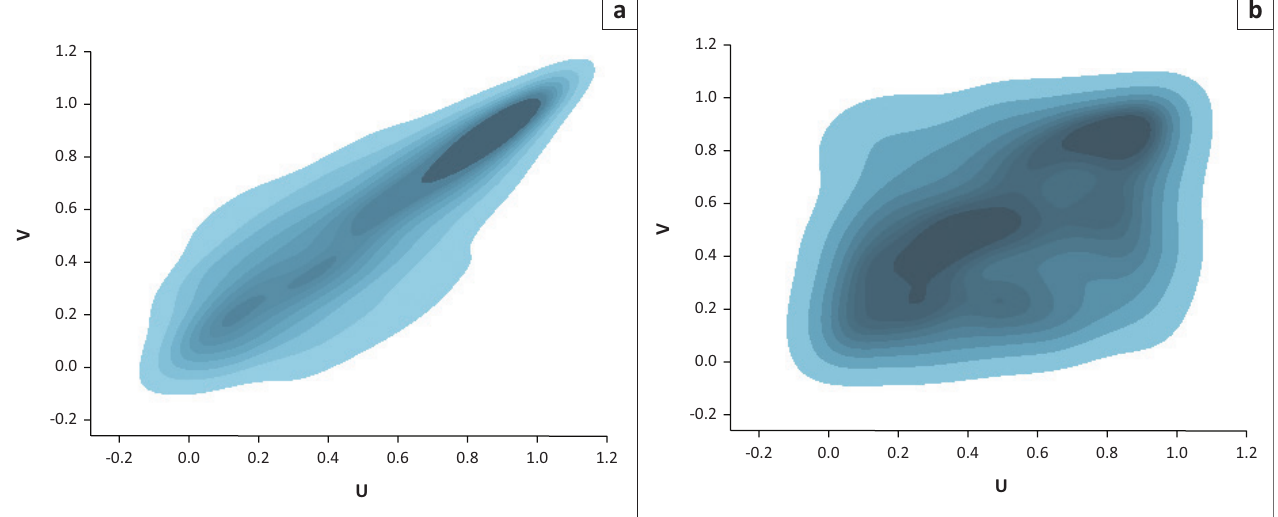
FIGURE 6: Contour plots of the dependence structures observed for ZAR and TRY where the Genest–Ghoudi copula covers the 6-month period ending June 2009, and the Ali-Mikhail-Haq copula the 6-month period ending June 2020